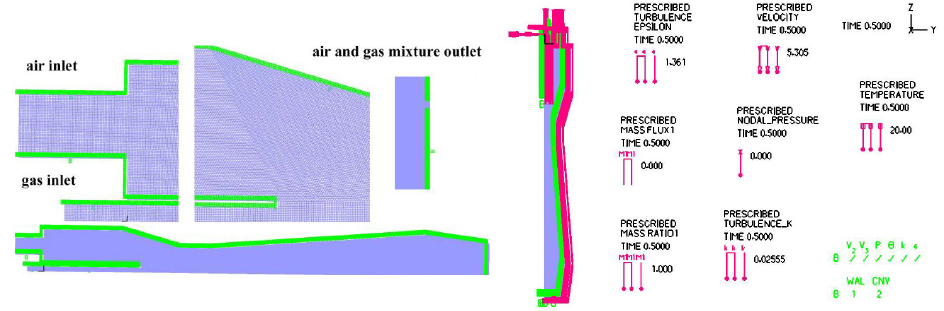
Figure 7. Mesh details for two-dimensional ADINA axisymmetric turbulent flow model with heat transfer and mass